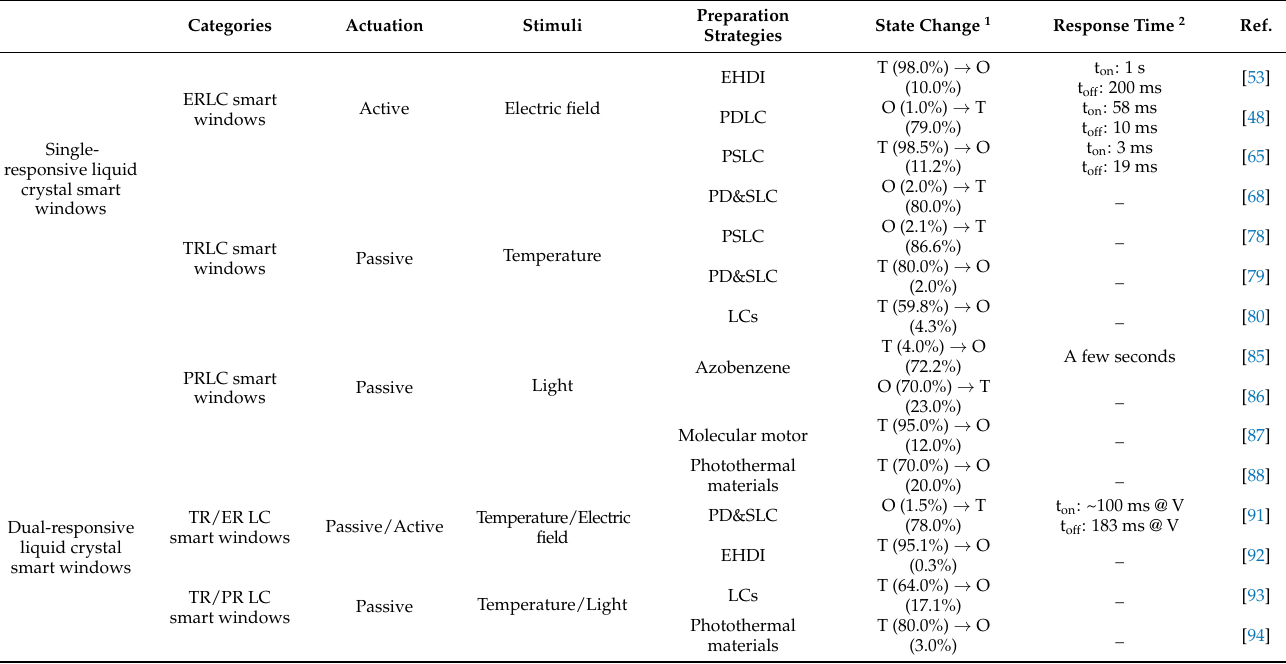
Table 1. A brief comparison of single- and dual-responsive LC smart